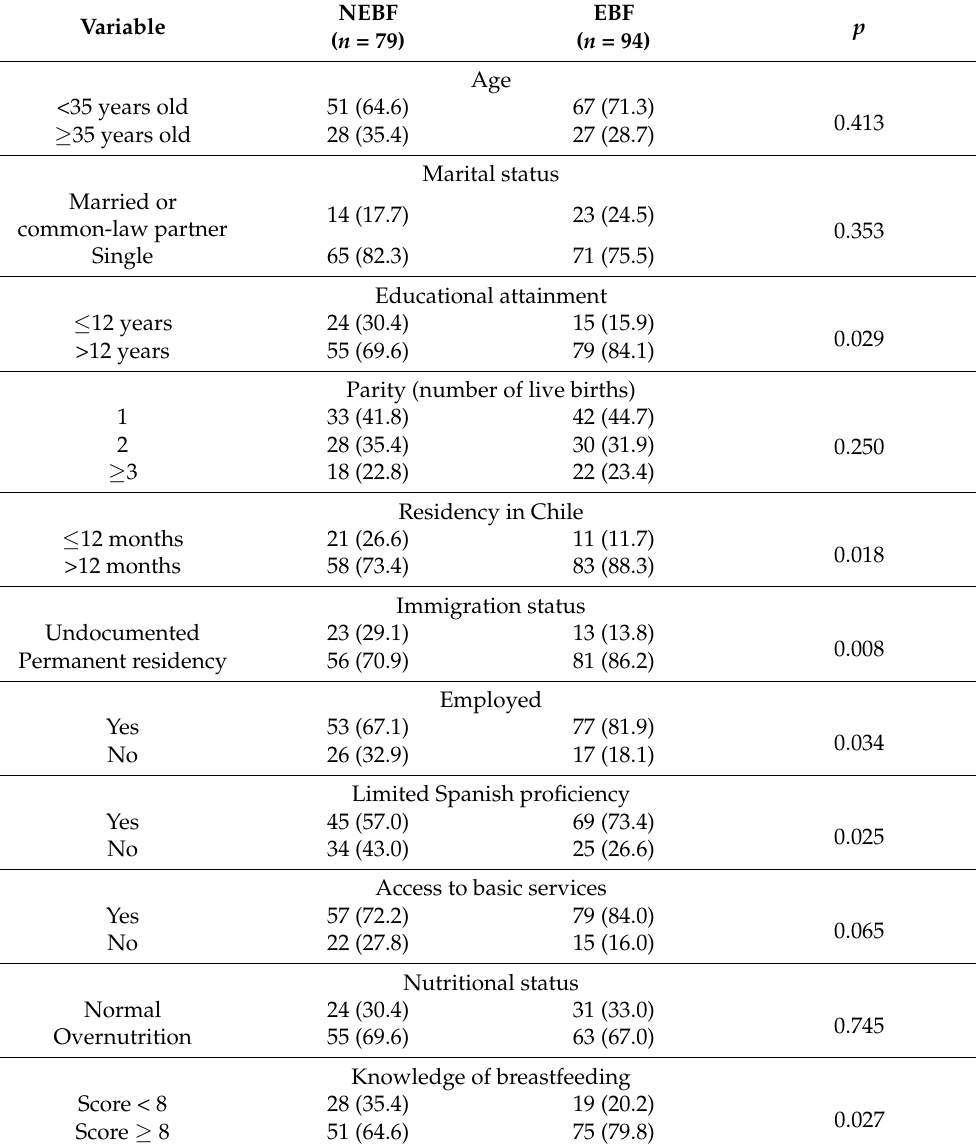
Table 2. Relationship between maternal factors and breastfeeding of Haitian immigrant women in southern